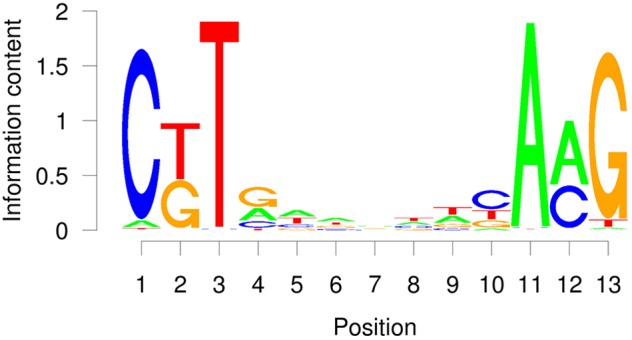
Average probability matrix motif for the VND, NST, and SND secondary cell wall NAC protein DAP-seq showing the probability of a nucleotide at each position.